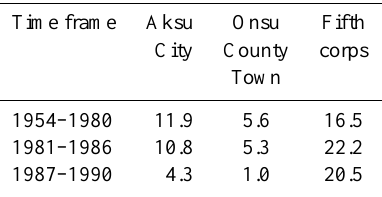
Table 4. Annual windborne sand events in the region of Aksu City 1954 to